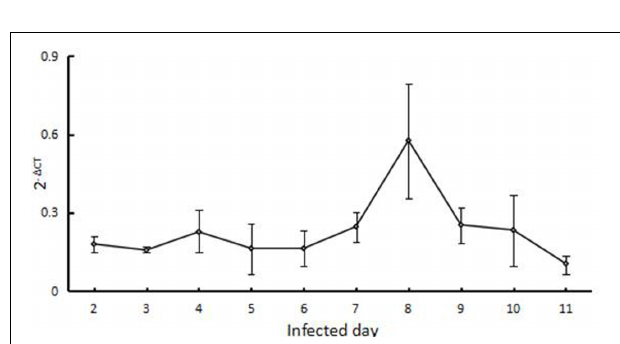
FIGURE 5 | Transcription analysis at the erythrocyte stage. x-axis refers to the day of infection of mouse RBCs with B. microti ; the y-axis refers to the relative BmTPx-2 expression level in mouse RBCs at different days after infection with B. microti by using the 2 − (cid:49)(cid:49) C T